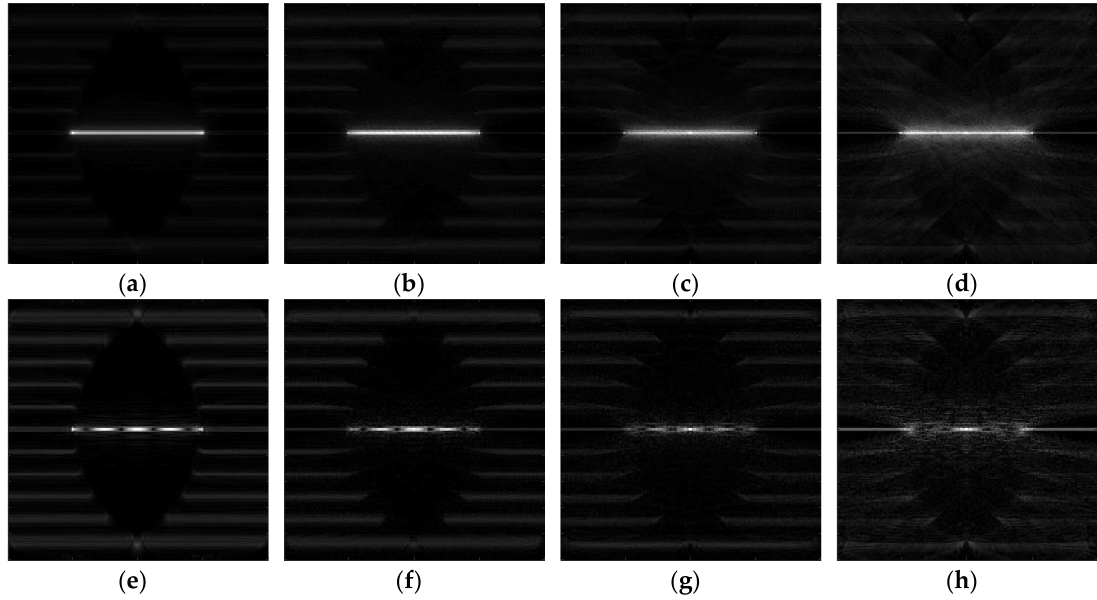
Figure 4. Single line target imaging based on piecewise linear transformation: ( a , e ) T = 0.5, k 1 = 1.5, k 2 = 0.5; ( b , f ) T = 0.8, k 1 = 1.2, k 2 = 0.1; ( c , g ) T = 0.9, k 1 = 1.2, k 2 = 0.1; ( d , h ) T = 0.95, k 1 = 1.2, k 2 = 0.1.